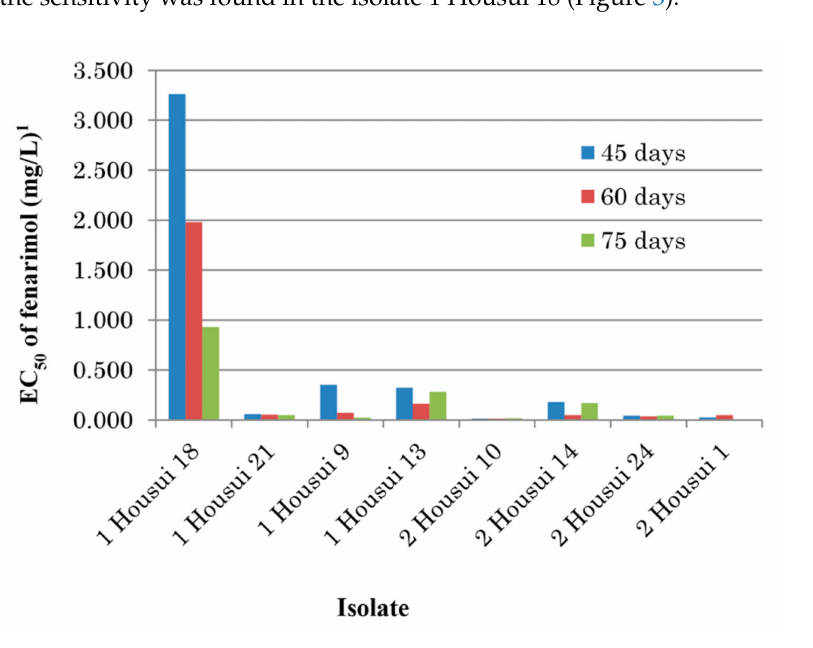
Figure 3. Influence of precultivation period against fenarimol sensitivity in single-spore isolates of Venturia nashicola . 1 Average values of two